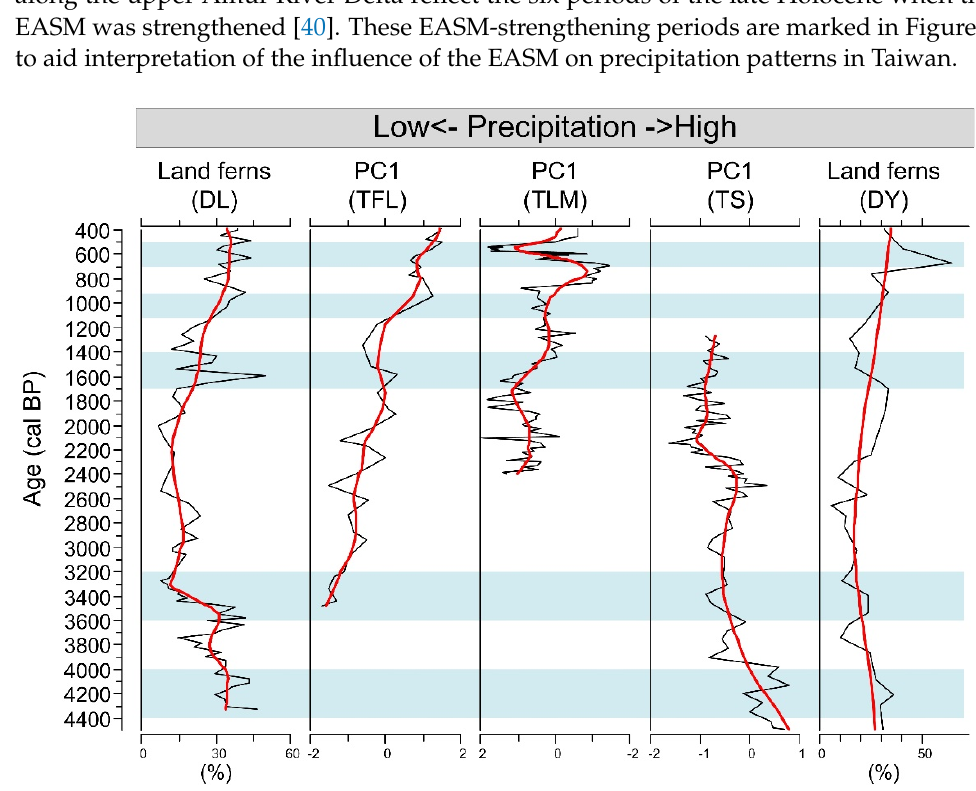
Figure 9. Summary diagram for proxy-inferred paleo-precipitation in northern (DL, this study), northeastern (TFL, [36]), central (TLM, [37], TS, [38]), and southern Taiwan (DY, [34]) over the last 4500 cal BP. The blue bars represent periods of intense East Asian summer monsoon, based on historical records of flooding periods along the upper Amur River Delta [40].